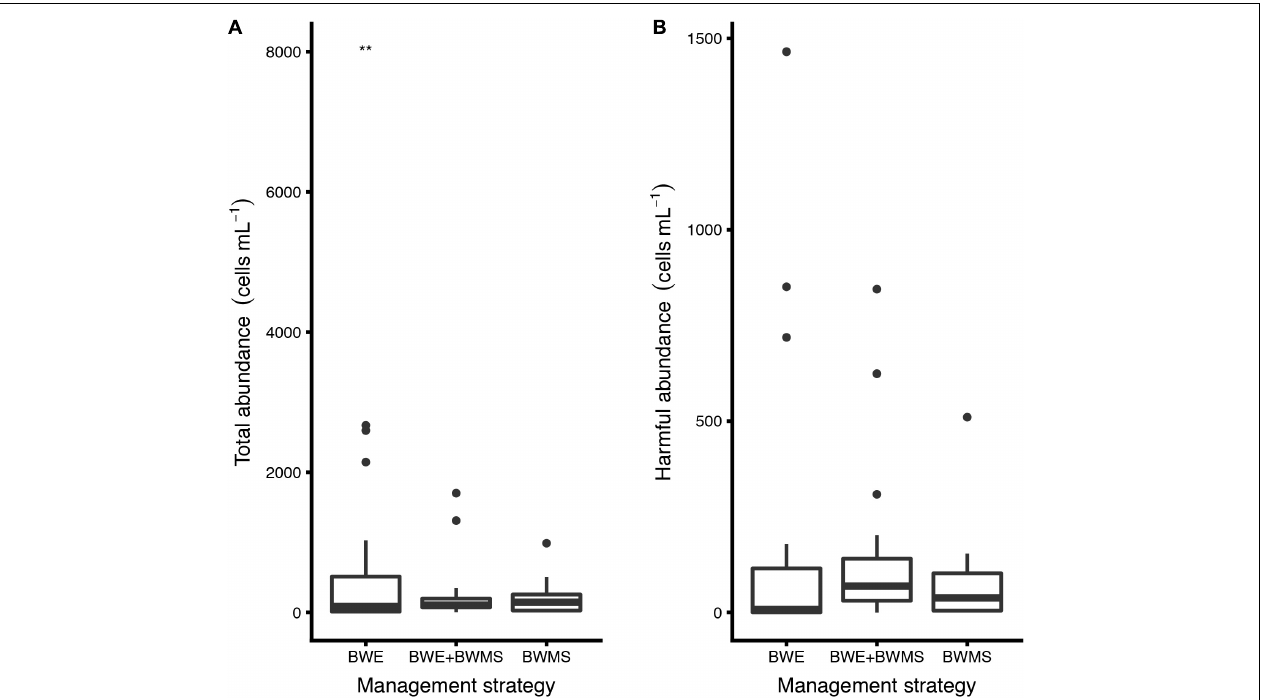
FIGURE 2 | Estimated abundance of (A) total and (B) harmful phytoplankton species in preserved ballast water samples collected from ships using different ballast water management strategies (BWMS, ballast water management system; BWE, ballast water exchange). In the box plots, the boundary of the box closest to zero indicates the 25th percentile, the black line within the box marks the median, and the boundary of the box farthest from zero indicates the 75th percentile. Whiskers above and below the box indicate the 10th and 90th percentiles. Points above the whiskers indicate outliers outside the 90th percentile. Note difference in scale for y -axis. Asterisks denote statistically significant differences ( p -value <